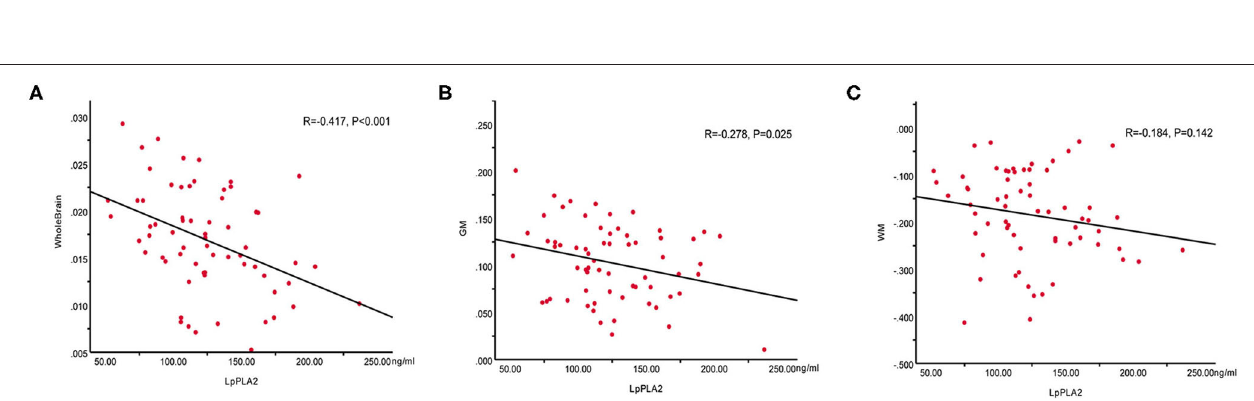
FIGURE 2 | Correlations between plasma Lp-PLA2 levels and CBF values in the whole brain, GM and WM in patients with WMHs. (A) Negative correlation between Lp-PLA2 levels and whole brain CBF. (B) Negative correlation between Lp-PLA2 levels and GM CBF. (C) No correlation between Lp-PLA2 levels and WM CBF. Lp-PLA2, lipoprotein-associated phospholipase A2; CBF, cerebral blood flow; GM, gray matter; WM, white matter; WMHs, white matter hyperintensities.